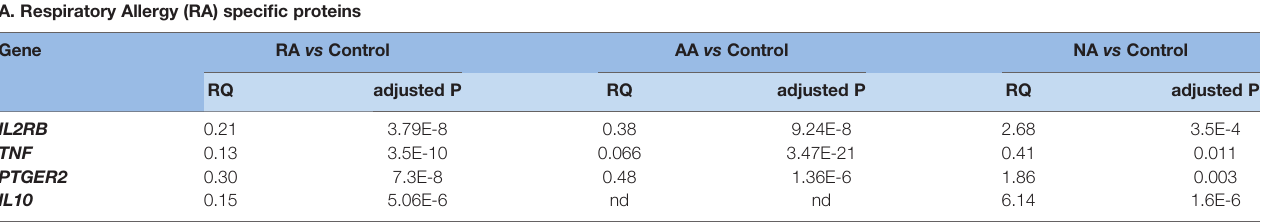
No data for IL-4, IL-9, and IL-2. nd, not